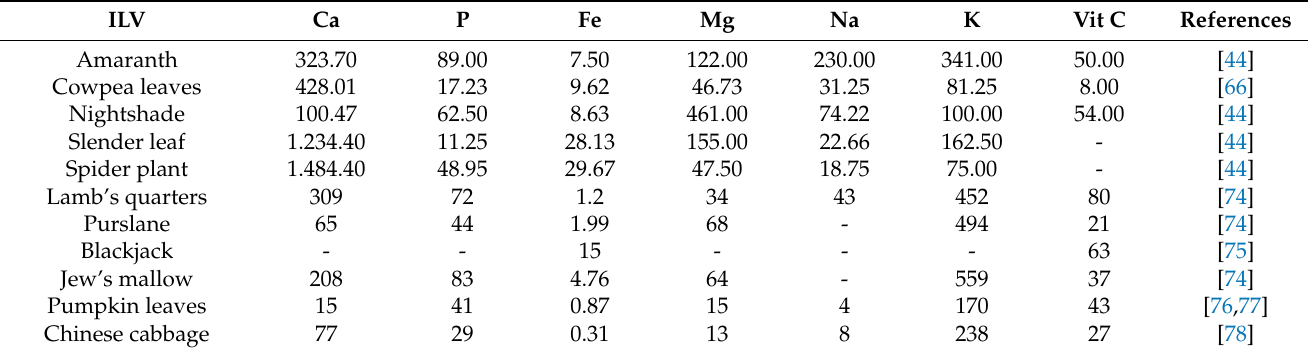
Table 2. Nutritional content of selected raw indigenous leafy vegetables (mg/100